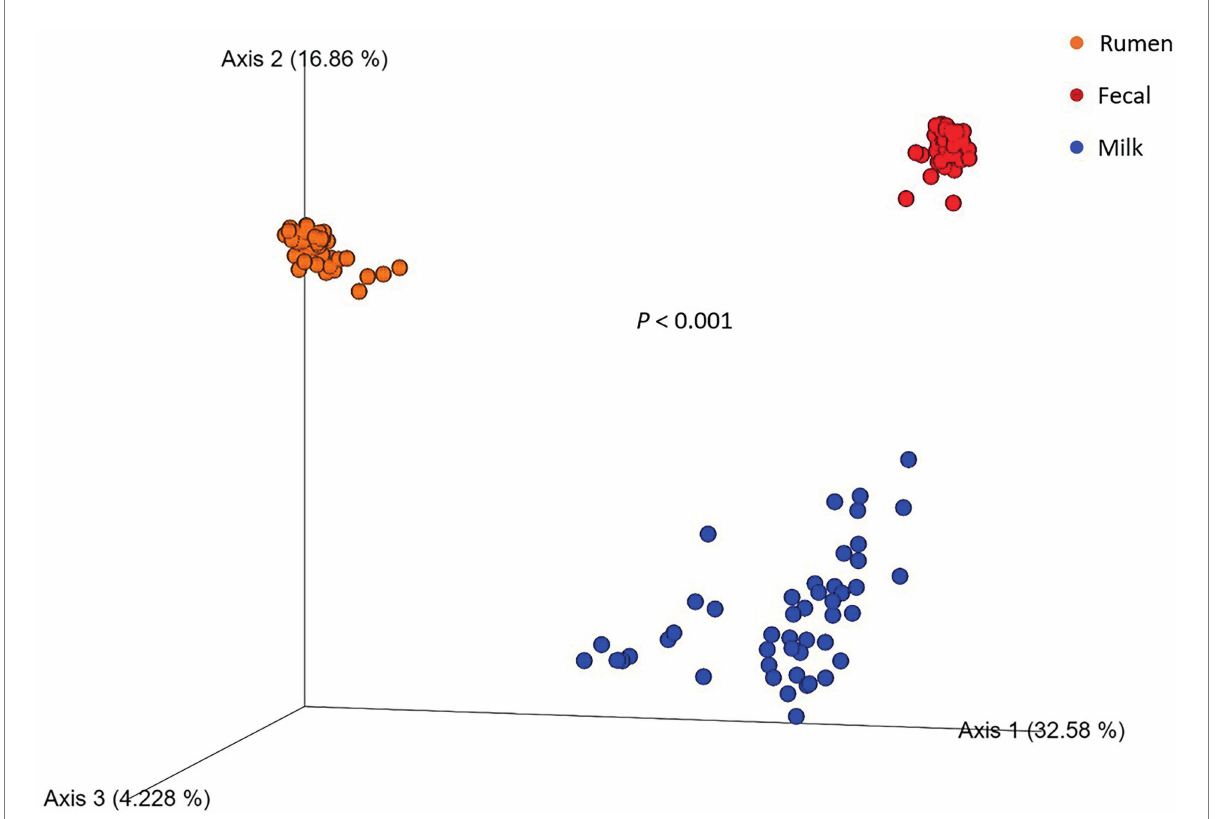
FIGURE 1 Principal coordinate analysis plot of beta diversity of rumen ( n = 51), fecal ( n = 51), and milk ( n = 47) microbial populations of Holstein dairy cattle using the unweighted UniFrac distance matrix. Value of p indicates a difference in beta diversity between sample